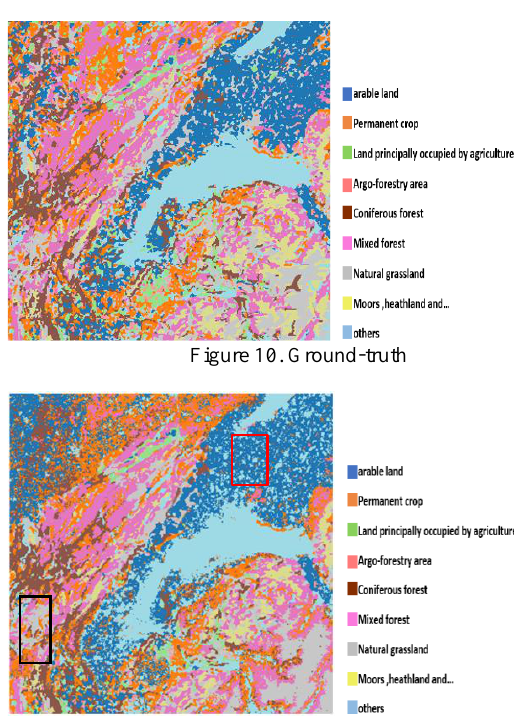
Figure 10. Ground-truth